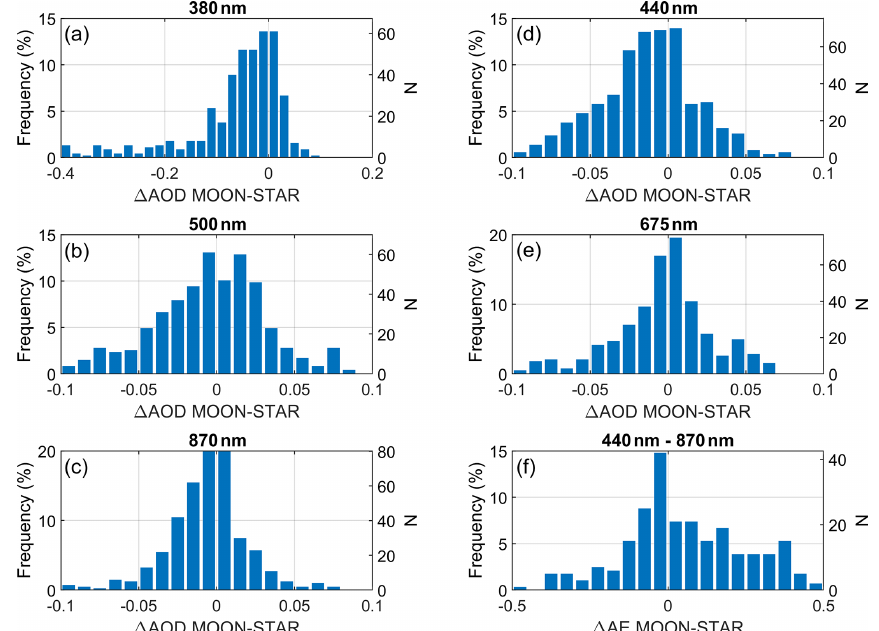
Figure 4. Frequency of the aerosol optical depth (AOD) differences between the Moon and star photometers for different wavelengths. Panel (f) shows the frequency of these differences for the Ångström exponent (AE) in the 440–870nm